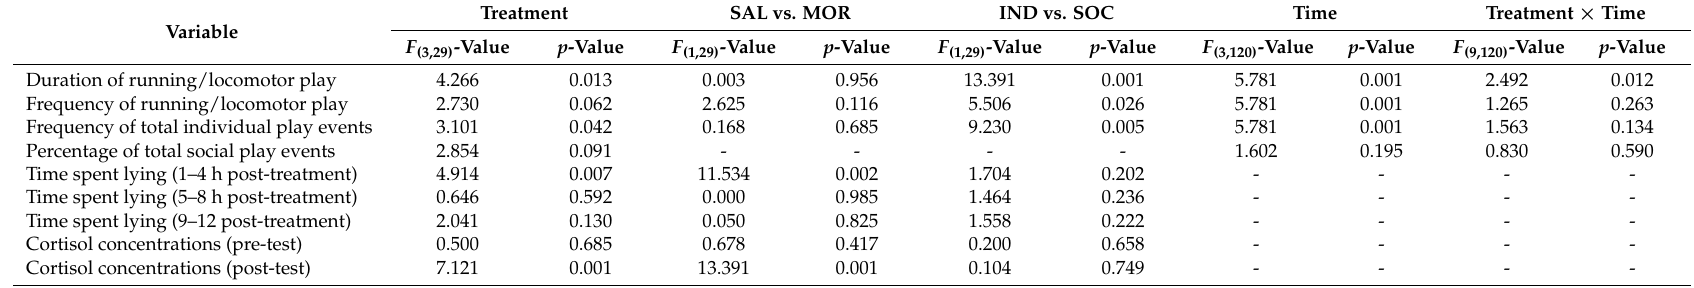
Table 2. F and p -values from statistical analysis for all measured variables. Calves received either an injection of saline (SAL) or morphine (MOR) and were tested either individually (IND) or in pairs (SOC) in an arena